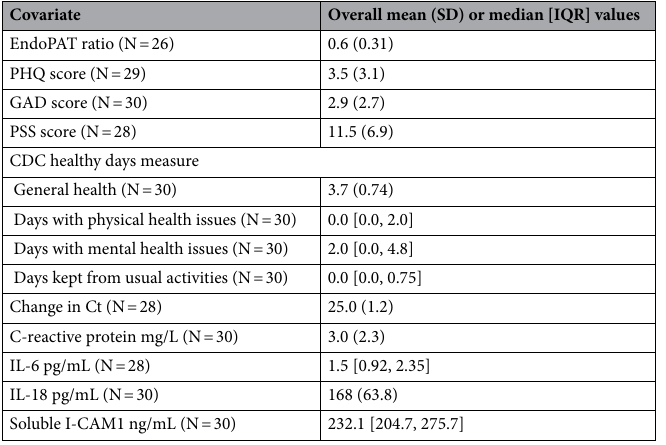
Table 2. Covariate measures for the study population. Values are mean (SD) or median [IQR] for numeric covariates where the median is used for highly skewed variables.